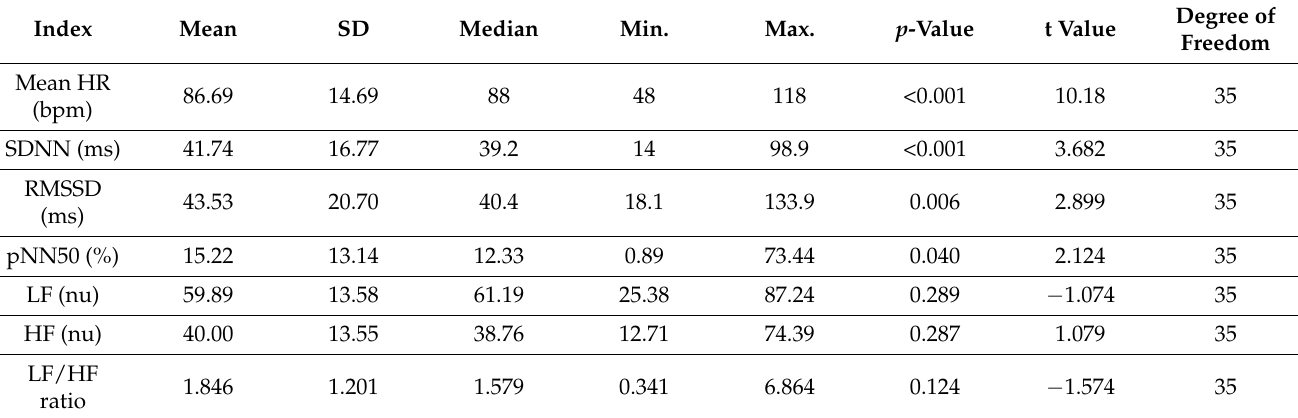
Table 3. Differences between day and night-time HRV indices in the sample population.